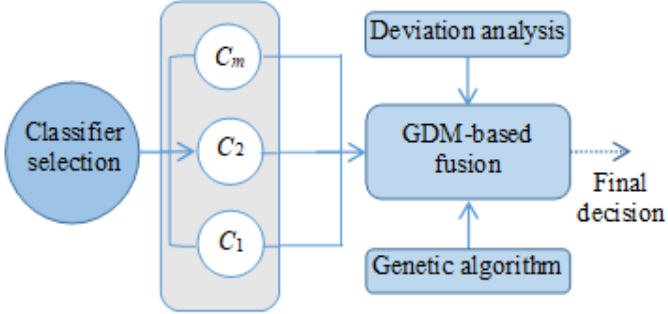
Figure 2. Generalized flowchart of the proposed GDM-based fusion phase.